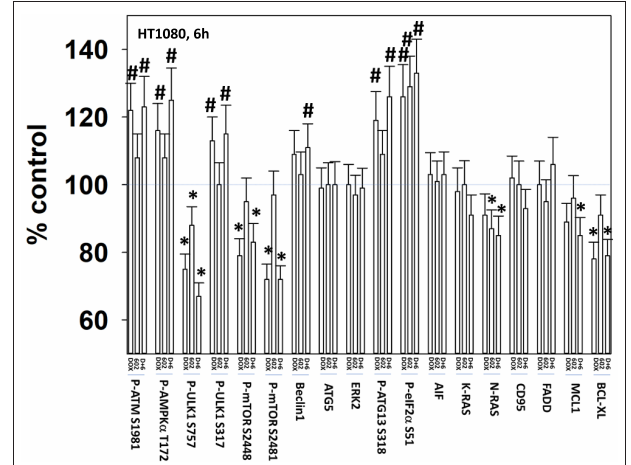
FIGURE 2 | GZ17-6.02 and doxorubicin interact after a 3h exposure to activate an ATM-AMPK-ULK1- autophagy pathway concomitant with inactivation of mTOR and increased Beclin1 expression. HT1080 human sarcoma cells were treated with vehicle control, GZ17-6.02 (2 µ M final curcumin), doxorubicin (200nM) or the drugs in combination for 3 and 6h. Cells were fixed in place and immunostained to detect the total expression and the total phosphorylation of the indicated proteins. The phosphorylation of each phosphoprotein was corrected for total protein expression; non-phosphoproteins had their expression corrected using invariant ERK2 expression. ( n = 3 + /–SD) * p < 0.05 less than vehicle control; # p < 0.05 greater than vehicle control.